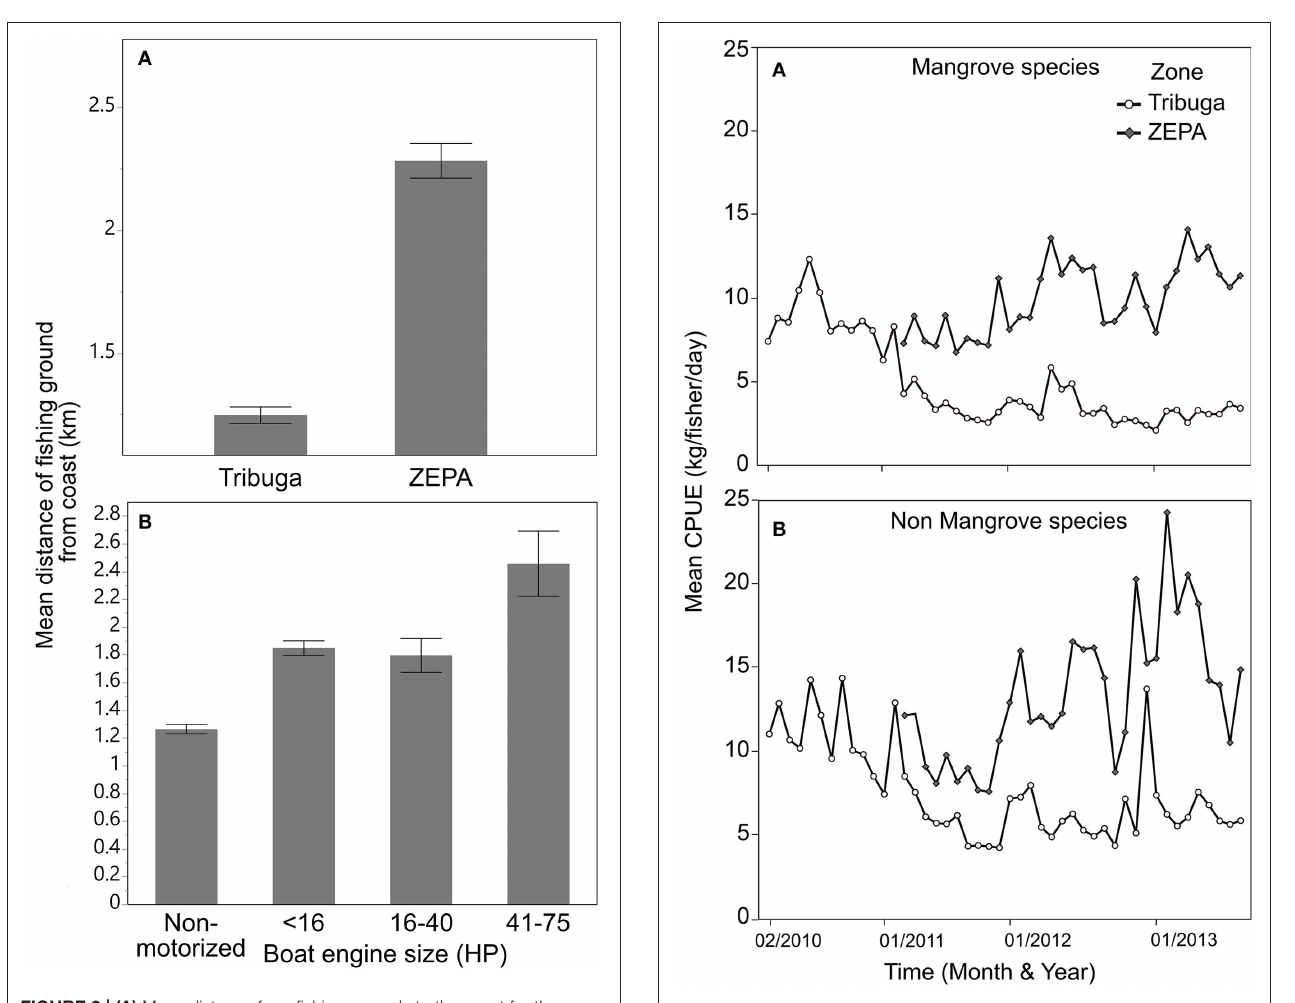
FIGURE 4 | Temporal changes in mean Catch per Unit Effort (CPUE) for (A) mangrove and (B) non-mangrove associated species, showing separate trend lines for the Exclusive Zone of Artisanal Fishing (ZEPA) (grey diamonds) and the Gulf of Tribugá (white circles) between 2010 and